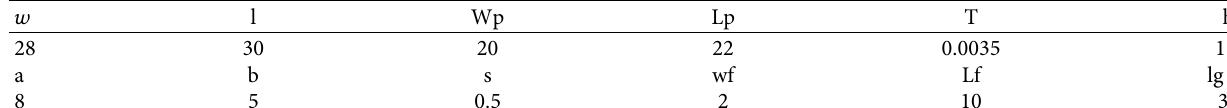
Figure 1: Evolution of HCSRR rectangular printed antenna. Table 1: HCSRR rectangular printed antenna parameters in mm.